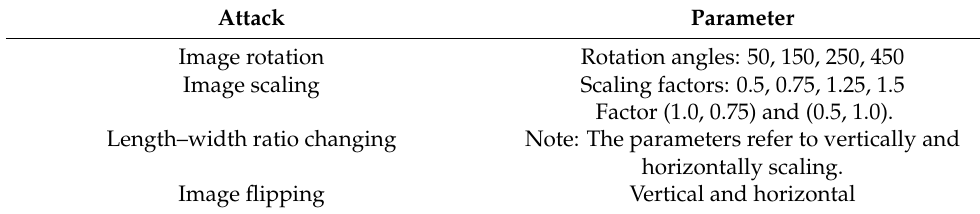
Table 3. Geometric attacks and their parameterization. Attack Parameter Image rotation Rotation angles: 50, 150, 250, 450 Image scaling Scaling factors: 0.5, 0.75, 1.25, 1.5 Factor (1.0, 0.75) and (0.5, 1.0). Length–width ratio changing horizontally scaling. Image flipping Vertical and horizontal